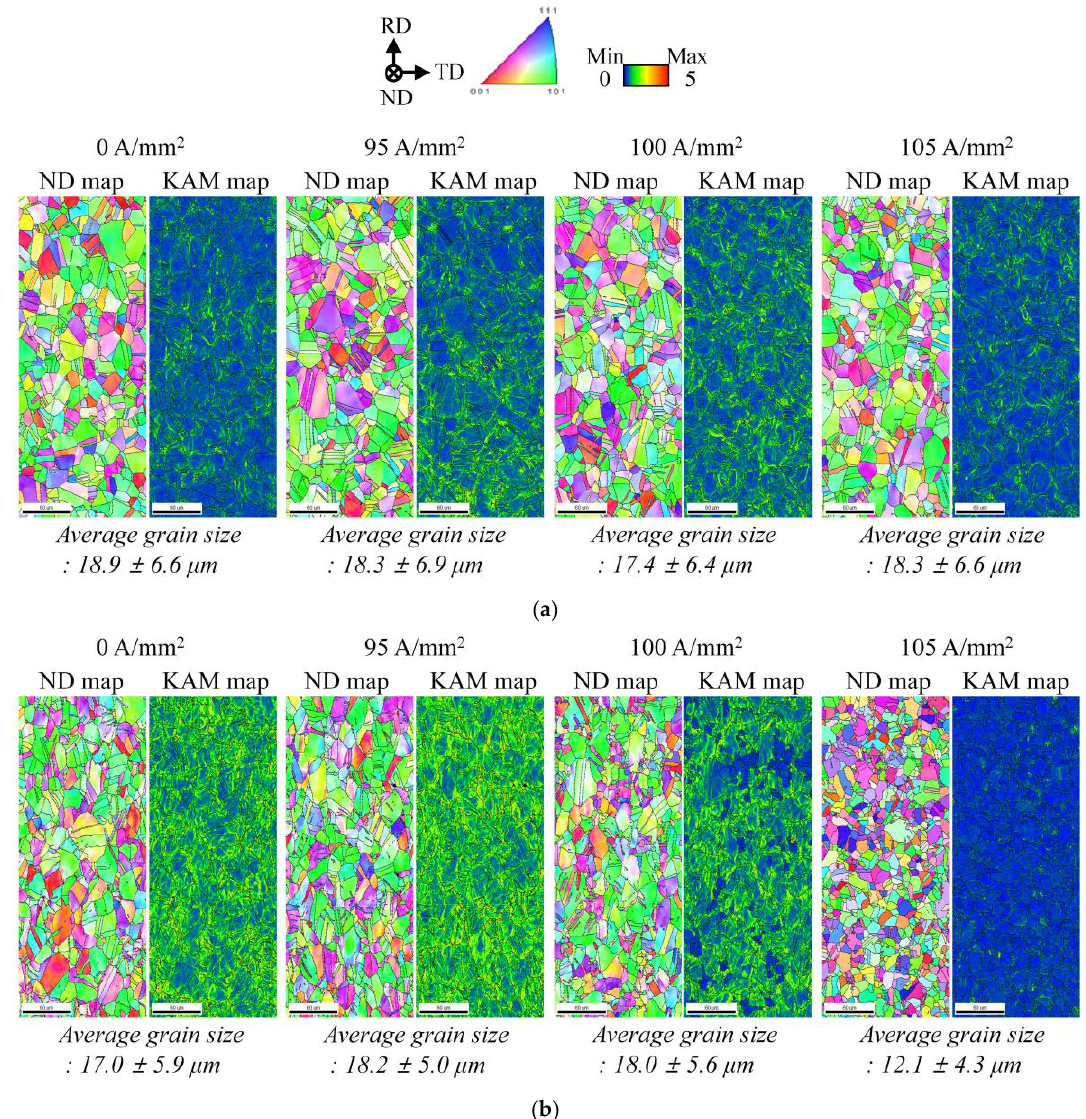
Figure 9. Electron backscatter diffraction (EBSD) inverse pole figures for normal direction (ND) and kernel average misorientation (KAM) maps of specimens with ( a ) 20% prestrain and ( b ) 60% prestrain for various electric current densities.